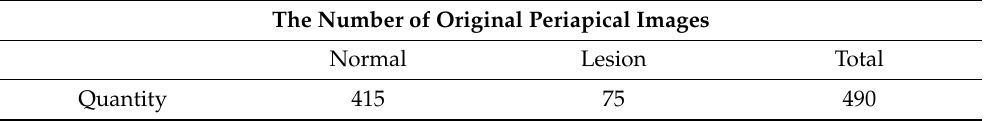
Table 2. Data distribution of the original periapical image from clinical.